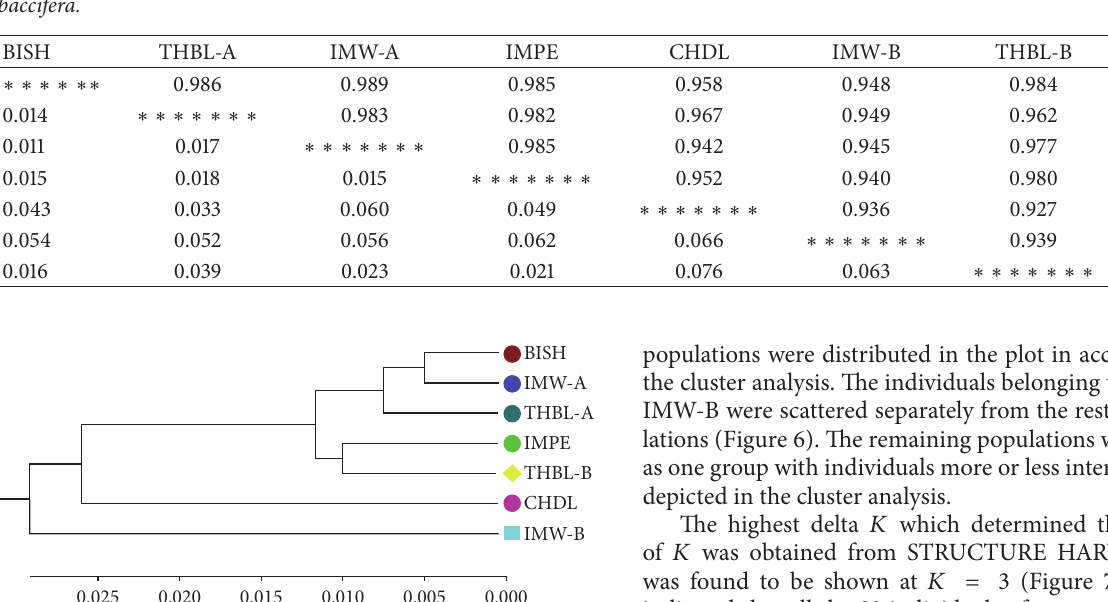
Table 4: Nei’s unbiased measures of genetic identity (above diagonal) and genetic distance (below diagonal) of the seven populations of M. baccifera.